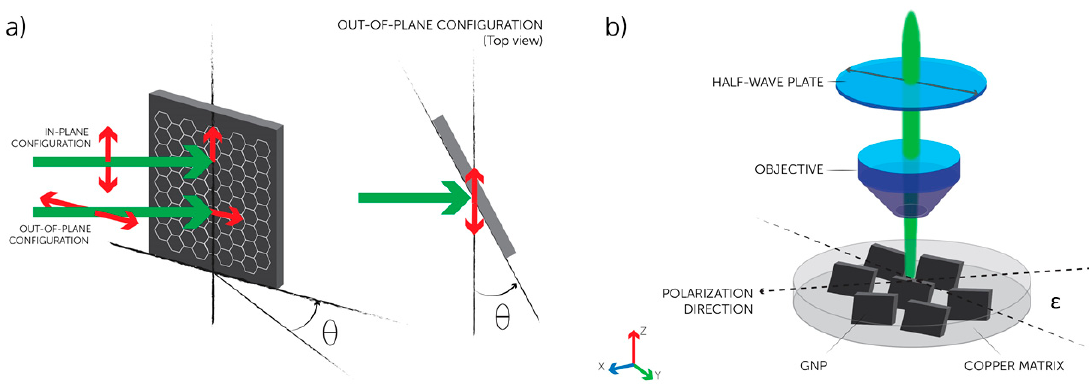
Figure 2. Schematic diagram of the polarization configurations and set up in our polarized Raman spectroscopy. ( a ) The inset shows the two configurations for an oblique laser incidence on a GnP plane ( θ (cid:54) = 0 ) depending on the polarization direction of the incident light; and ( b ) the measurement setup for polarized Raman spectroscopy in ‘VV’ configuration.